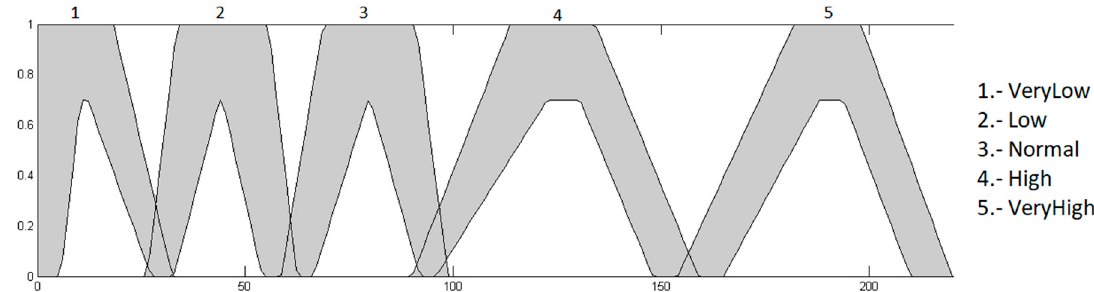
Figure 26. Optimized input heart rate with trapezoidal MFs.